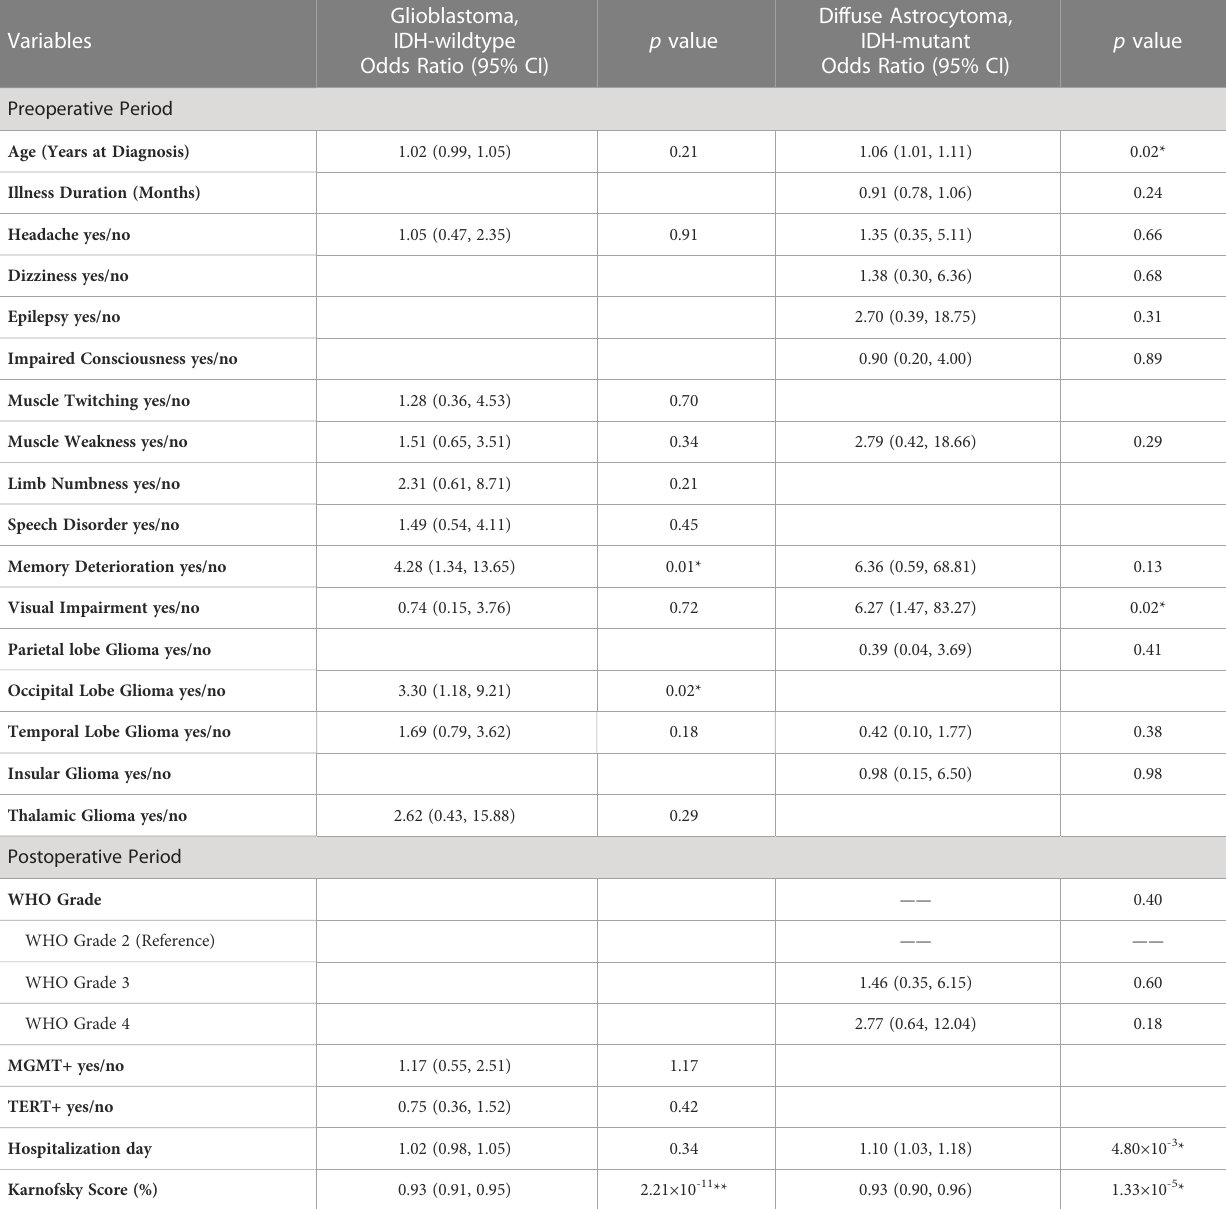
TABLE 3 Multivariable logistic regression model for predicting postoperative mental health disorders in different subgroups of glioma patients.